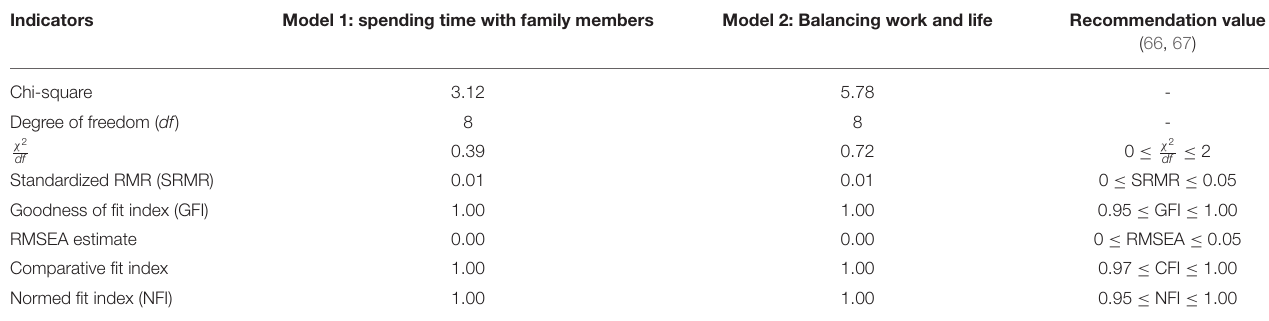
TABLE 3 | The goodness of fit indices of the structural equation models. Indicators Model 1: spending time with family members